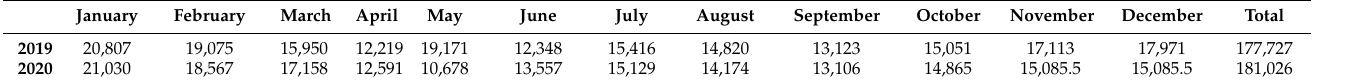
Table 1. Electricity consumption of the pilot site in